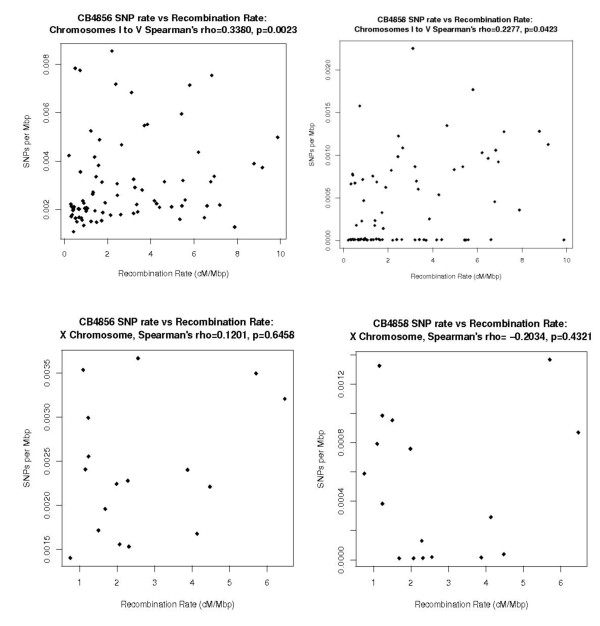
SNP rates vs. Recombination Rates for CB4856 and CB4858.